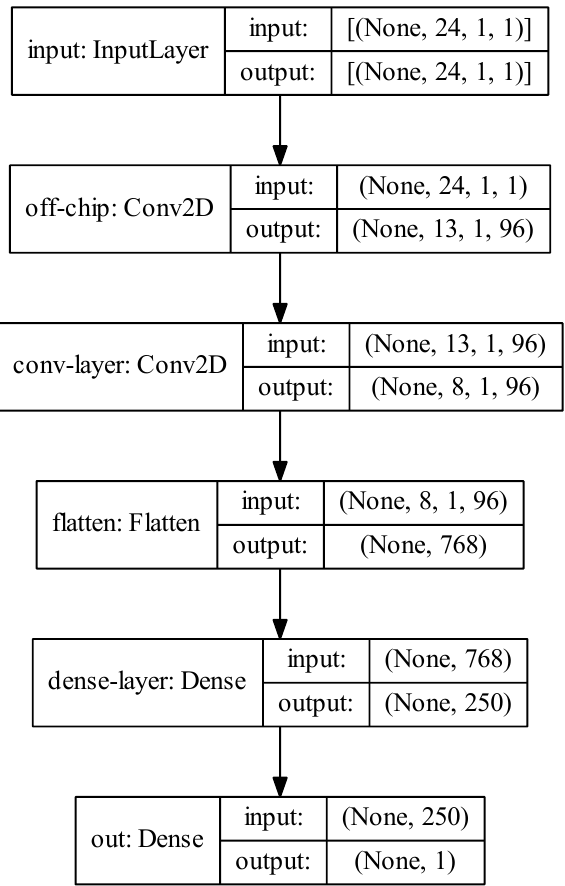
Figure 2. SNN model